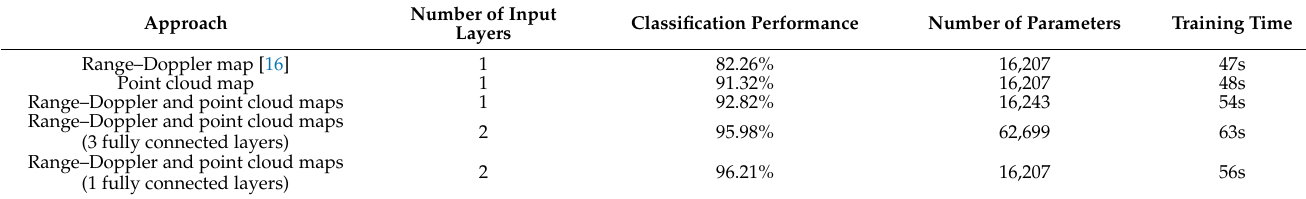
Table 2. Identification results according to approach and number of the input layer.